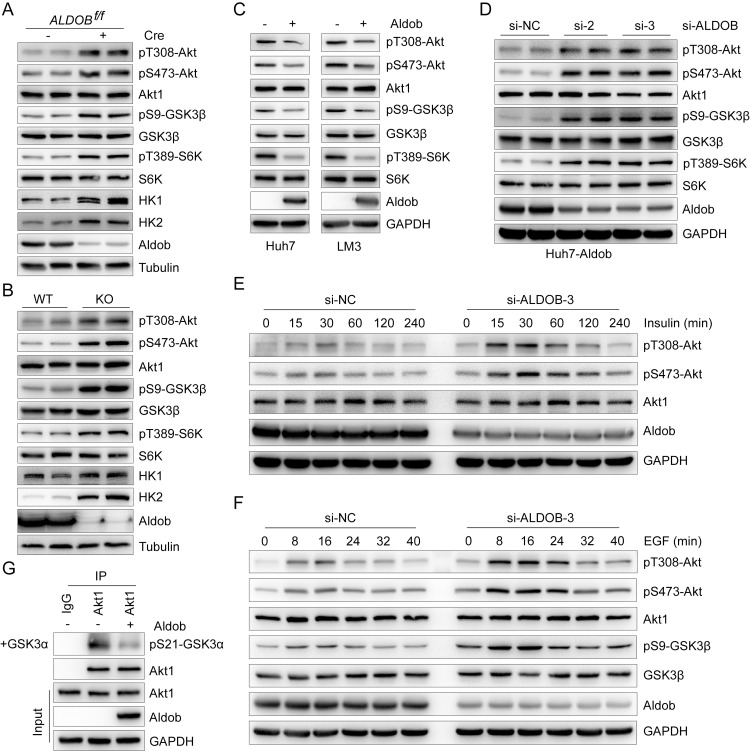
Aldob suppresses Akt phosphorylation and kinase activity.(A) IB analysis of WCL derived from conditional ALDOB KO and WT mouse primary hepatocytes. (B) IB analysis of WCL derived from liver tumor tissues of ALDOB KO and WT mice after injection with DEN at postnatal day 14 to induce hepatocellular carcinoma for 10 months. (C) IB analysis of WCL derived from Huh7 and LM3 cells stably expressing Aldob via lentiviral infection (with Vector as a negative control). (D) IB analysis of WCL derived from Huh7-Aldob cells transfected with indicated siRNAs (si-NC as a negative control). (E and F) IB analysis of WCL derived from Huh7-Aldob cells transfected with indicated siRNAs. Resulting cells were serum-starved for 24 hours and then stimulated with 0.1 μM insulin (E) or 100 ng/ml EGF (F) at the indicated time before harvesting. (G) In vitro Akt1 kinase assay was conducted with recombinant GSK3α as a substrate and immunoprecipitated Akt1 from Huh7-Vector or Huh7-Aldob cells as the source of kinase. IgG was used as a negative control. The data underlying this figure can be found in S1 Data. Aldob, aldolase B; DEN, diethyl nitrosamine; EGF, epidermal growth factor; GSK3α, glycogen synthase kinase 3α; Huh7-Aldob, Aldob-overexpressing Huh7; IB, immunoblot; IgG, immunoglobulin G; KO, knockout; siRNA, small interfering RNA; WCL, whole cell lysate; WT, wild-type.